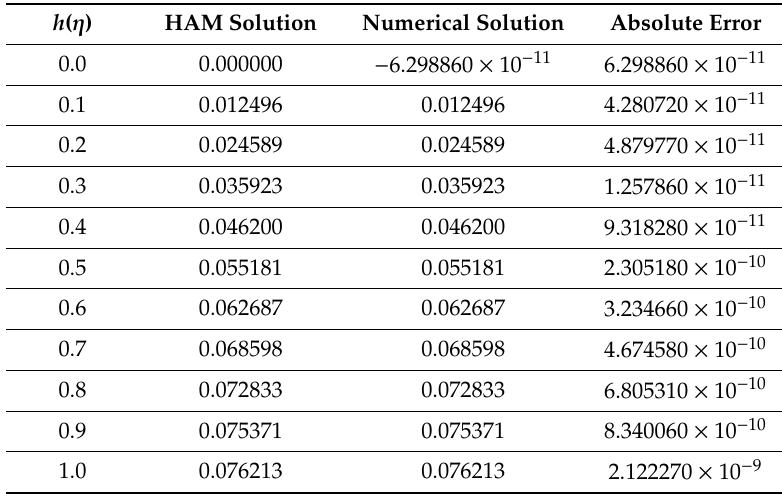
Table 4. Comparisons of the HAM and numerical solution.